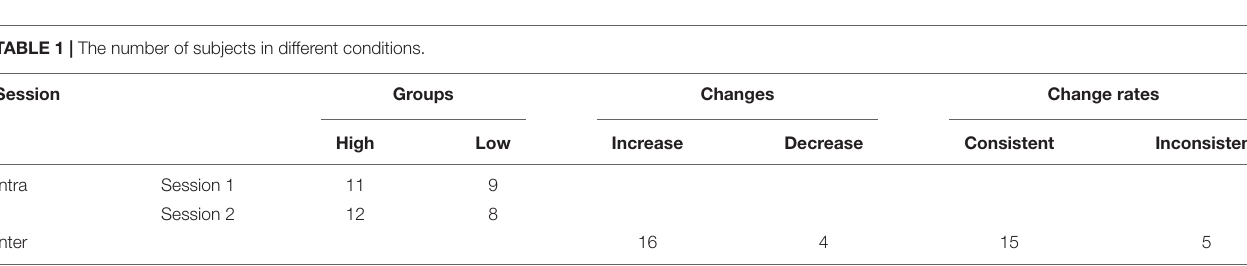
TABLE 1 | The number of subjects in different